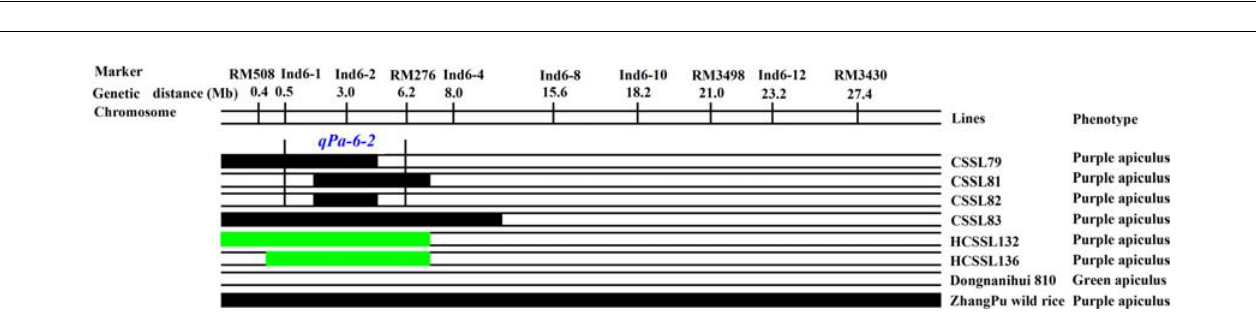
FIGURE 7 | Substitution mapping of plant height. (A) Substitution mapping of the qPH-1-1 gene on rice chromosome 1; (B) Substitution mapping of the qPH-7-1 gene on rice chromosome 7. The substituted segments from ZhangPu wild rice were denoted by dark bars. The substituted segments from ZhangPu wild rice were denoted by black bars with the assumption that a segment flanked by one marker of donor type and one marker of recipient type was 50% donor genotype. Note: ∗∗ Shows significant at 0.01 level. For the purposes of mapping, however, the full region between one marker of donor type and one marker of recipient type was used as the boundary on each end. The vertical bars through the CSSLs designate the region to which the gene was mapped.